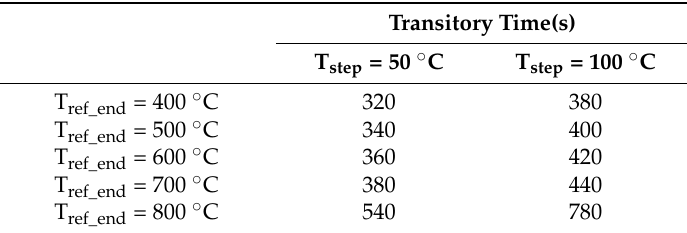
Table 2. Transient time values for CMO-25-42S at the reference temperatures ( T ref_end ) of 400 ˝